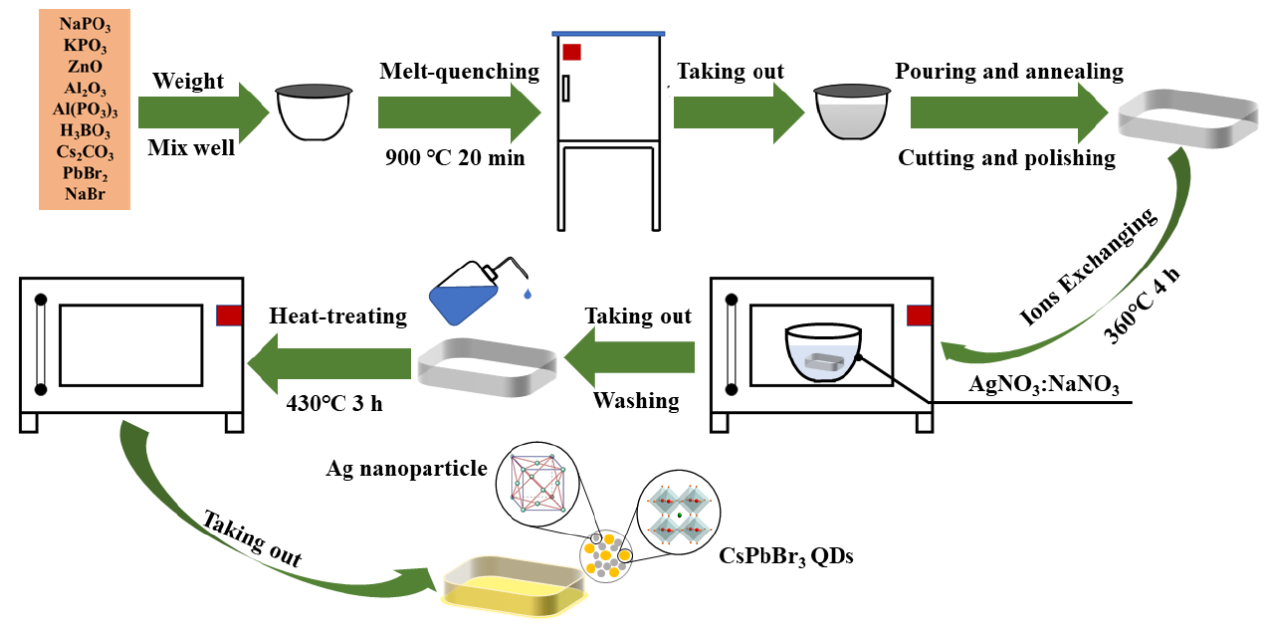
Figure 1. Schematic diagram of the preparation of PG glass and CsPbBr 3 QD-doped glasses containing Ag NPs.